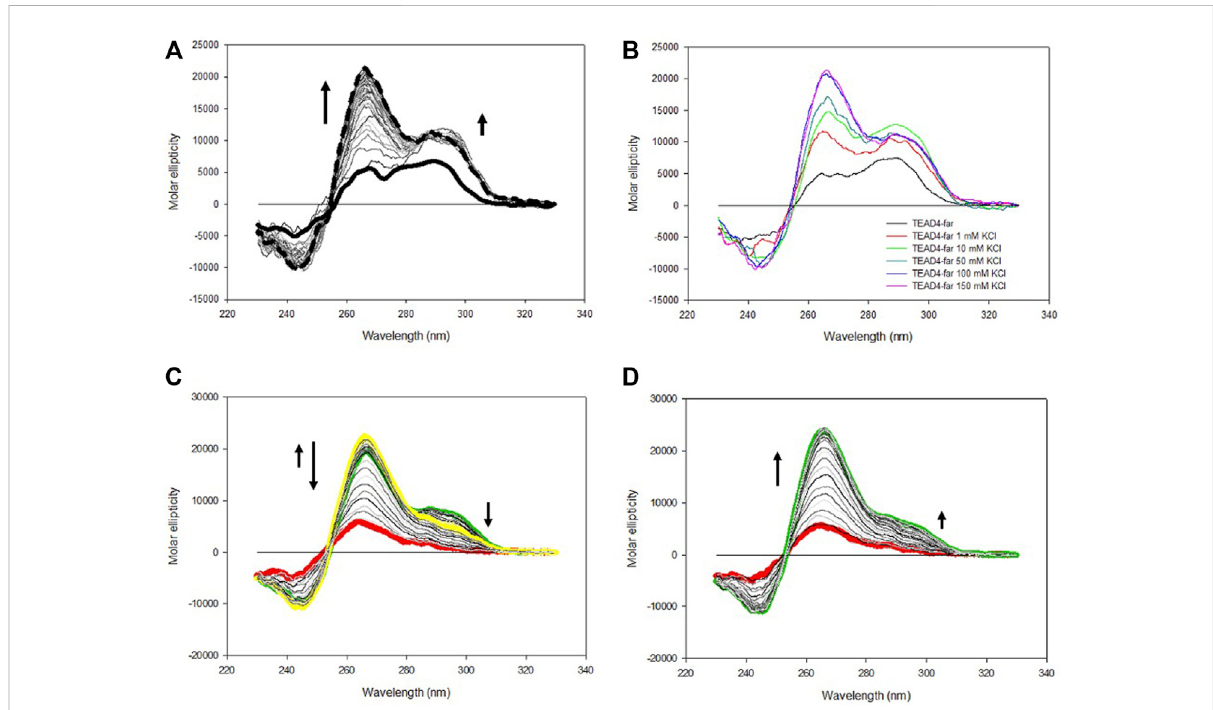
FIGURE 4 (A) TimedependentvariationofCDspectraof4 µMTEAD4-farin5 mMTris,pH7.5uponadditionof150 mMKClat25 ° C.Solidanddashedlines correspond to the oligonucleotide in the absence of metal ion and after 1 h incubation, respectively. (B) CD spectra of 4 µM TEAD4-far in 5 mM Tris pH 7.5 in the absence and presence of 1 – 150 mM KCl acquired after 1 h at 25 ° C. (C) and (D) CD spectra of 4 µM TEAD4-far in 5 mM Tris pH 7.5, 150 mM KCl, acquired during melting (C) or annealing (D) at 20 ° C/h. The green, yellow and red lines correspond to spectra acquired at 25, 65 and 95 ° C,